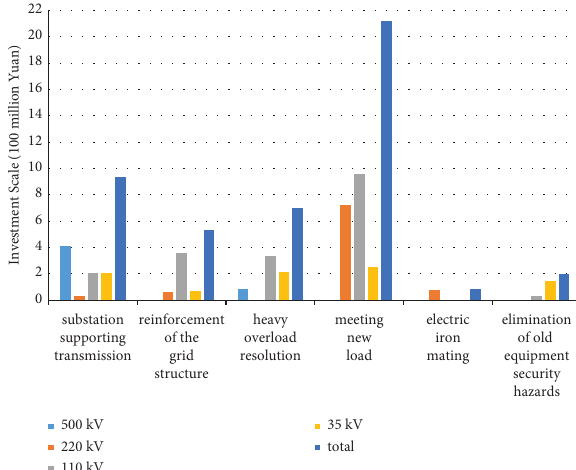
Figure 4: Optimal solution with a comprehensive balance objective at 500kV/220kV/110kV/35kV voltage